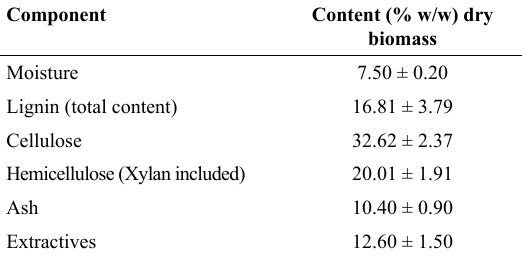
Table 1. Lignocellulosic composition of the Cereus Forbesii